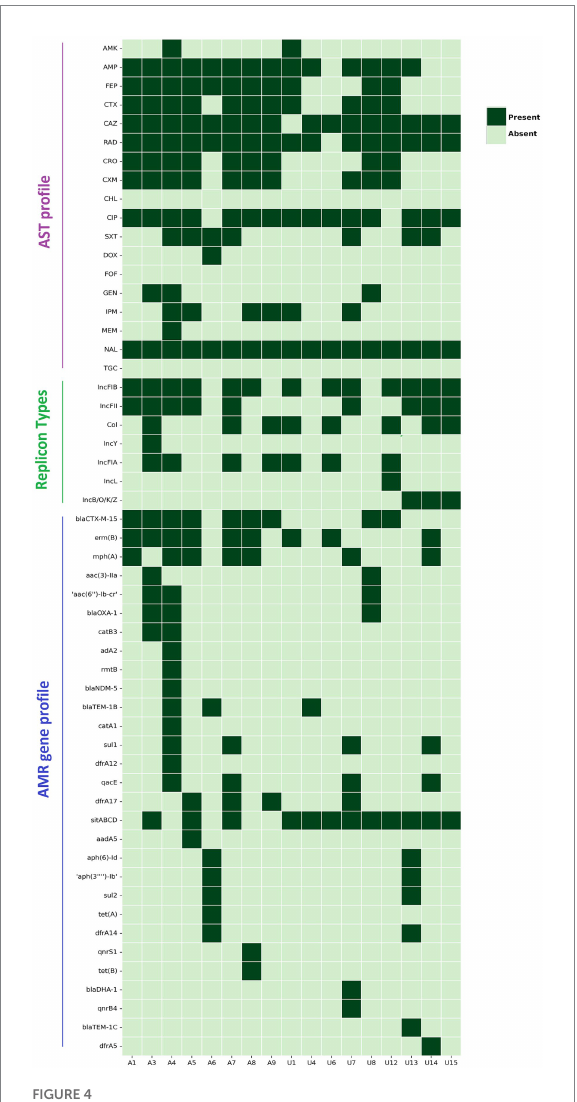
FIGURE 4 Heat map demonstrating the AST profile, plasmid replicon types and acquired AMR gene profile of 17 NLF E. coli isolates/genomes. Dark green represents resistance/presence, and light green blocks represent the sensitivity/absence of a particular trait. Definition of abbreviated antibiotics for AST: AMK, amikacin; Amp, ampicillin; FEP, cefepime; CTX, cefotaxime; CAZ, ceftazidime; RAD, cephradine; CRO, ceftriaxone; CXM, cefuroxime; CHL, chloramphenicol; CIP, ciprofloxacin; SXT, trimethoprim-sulfamethoxazole; DOX, doxycycline;